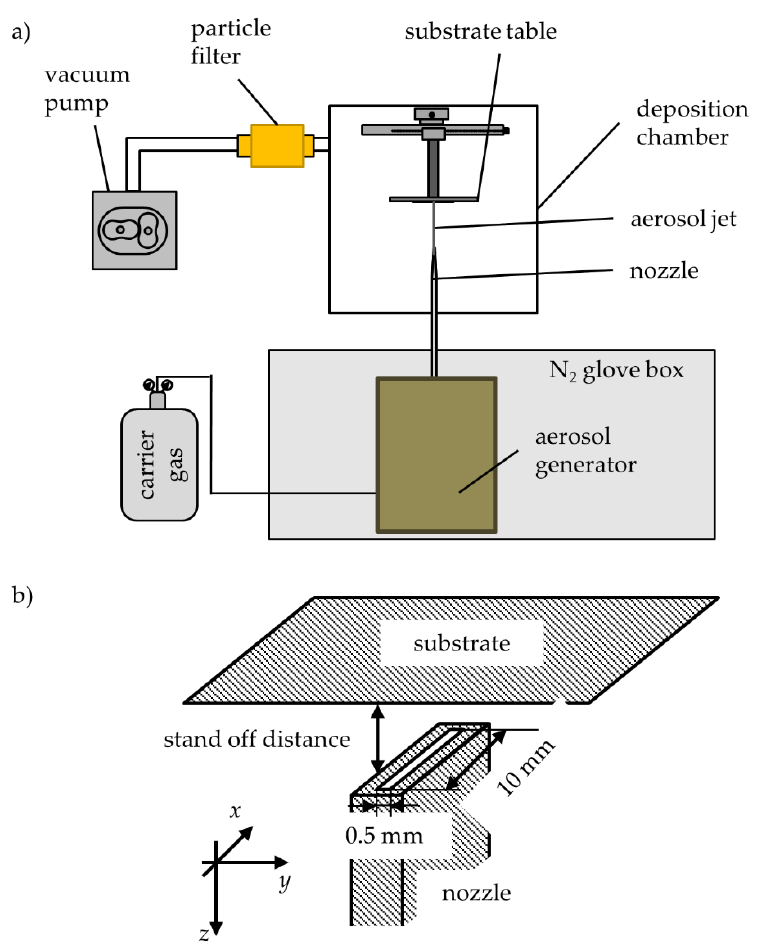
Figure 1. ( a ) Schematic drawing of an aerosol deposition device including deposition chamber, vacuum pump, and aerosol generating unit; ( b ) sketch of the nozzle-substrate-positioning. During deposition, the substrates moves in positive or negative y -directions. The number of scans has significant effect on the film thickness [6]. Other parameters, such as the pressure ratio (stagnation pressure to backpressure), total carrier gas flow, and the particle size distribution of the powders, also need to be controlled for the successful pro- duction of film coatings by PAD.